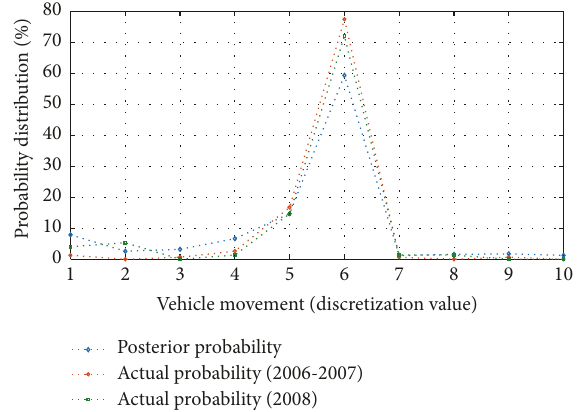
Figure 6: The comparison of posterior and actual probability curves of vehicle movement when the evidence variable is “rear